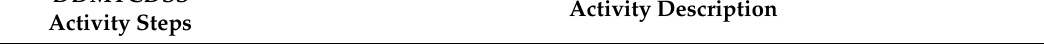
Table 5. Iterative design steps for the framework for the development of Data-driven Mamdani-type CDSS.